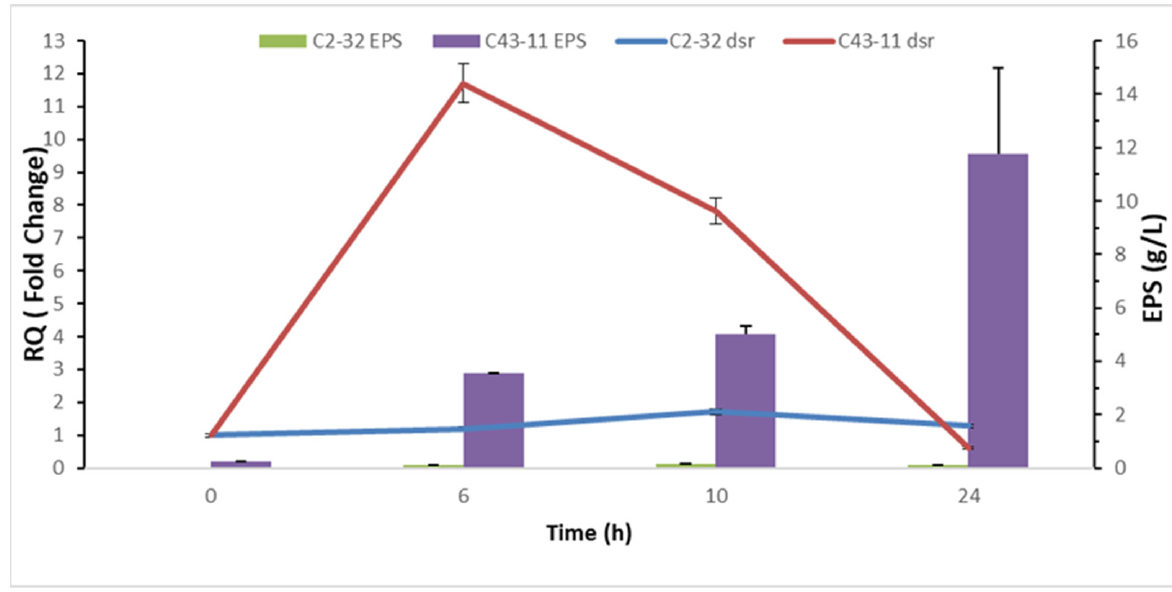
Figure 6. Relative Quantification (RQ, Fold Change = 2 −ΔΔ Ct ) of dsr gene expression in W. cibaria C43-11 and C2-32 grown in mMRS with sucrose (10% w / w ). Reported RQ (lines) refer to dsr gene expression in mMRS with sucrose (mMRS + S) as compared to mMRS. RQ values are correlated with EPS production (g/L) for each strain in mMRS + S (bars).